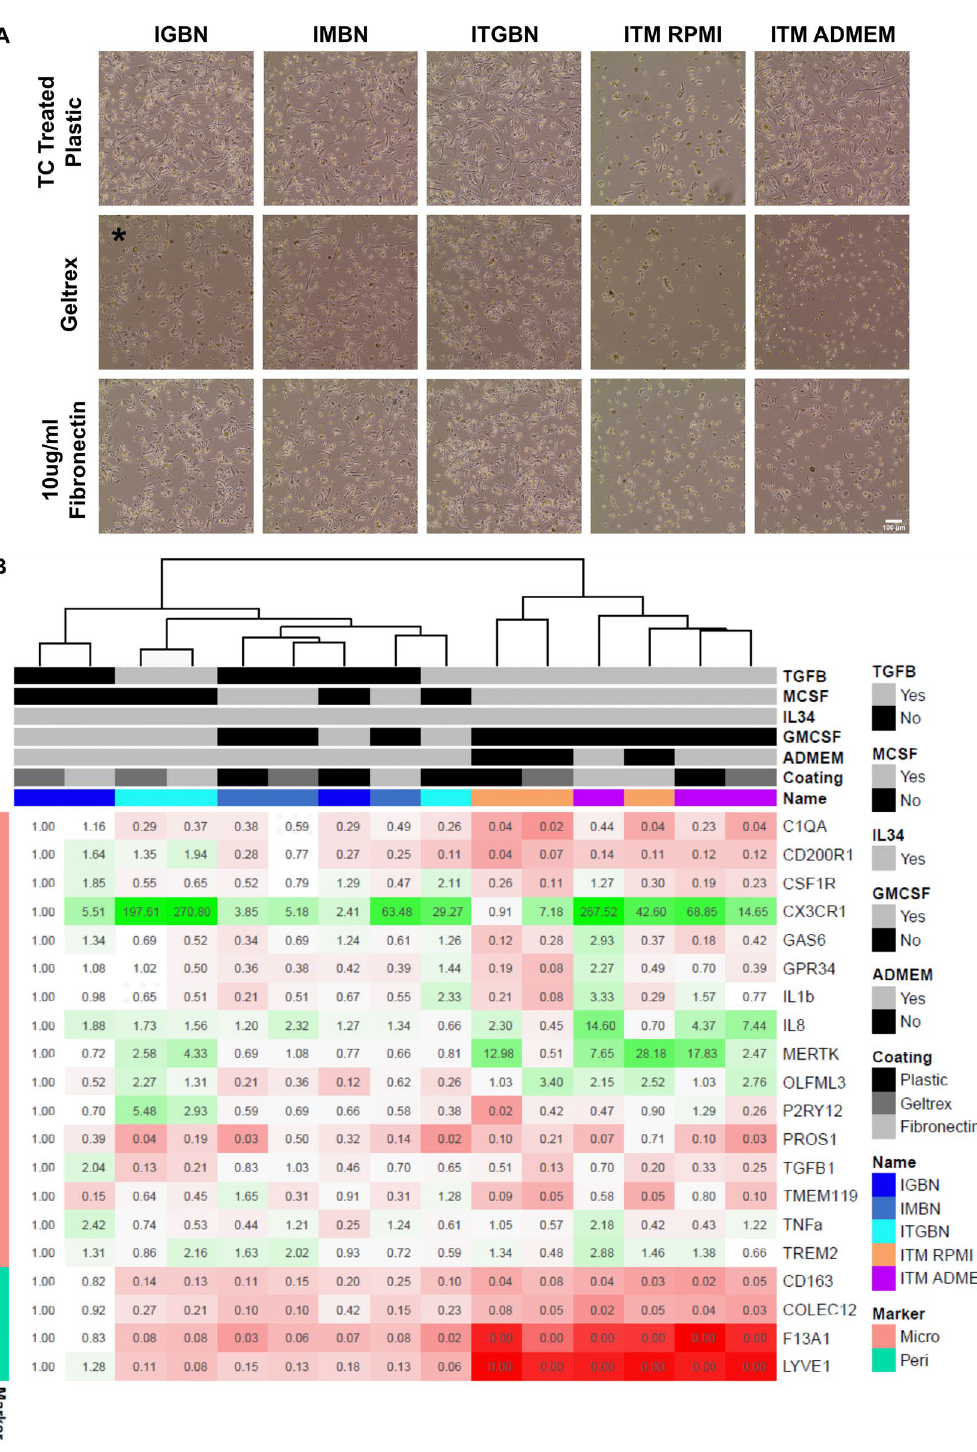
Figure 3. TGF-β1 promotes microglial identity, and M-CSF promotes macrophage identity, tissue culture coating influences morphology but medium factors are the main driver of identity. ( A ) Morphology of iPSC-microglia cultured for 14 days in five different media combinations on either tissue culture treated plastic, Geltrex, or 10 µg/mL fibronectin. Each letter corresponds to a growth factor or compound; I IL-34, T TGF-β1, M M-CSF, G GM-CSF, B β-mercaptoethanol, N N-2 supplement. Phase contrast images taken at ×10 magnification, scale bar 100 µm. * media IGBN is media published by Haenseler et al., and is the baseline for comparison. Geltrex resulted in the fewest cells per media condition, followed by fibronectin, with TC treated plastic resulted in the highest cell number. ITM with RPMI base medium results in a large reduction of cell numbers compared to the medium with ADMEM/F12 base. ( B ) qPCR of the 15 samples in ( A ) for microglial and perivascular macrophage markers, fold changes represented relative to IGBN Geltrex (the Haenseler et al. protocol). Fold changes are presented as both colour changes (green indicates increased expression, red decrease expression) and the number within each cell. Samples cluster by medium, with medium containing TGF-β1 showing lower expression of perivascular macrophage genes ( F13A1/LYVE1/COLEC12) and increased microglial genes ( CX3CR1/ MERTK/OLFML3). Heatmap generated in R using the pheatmap